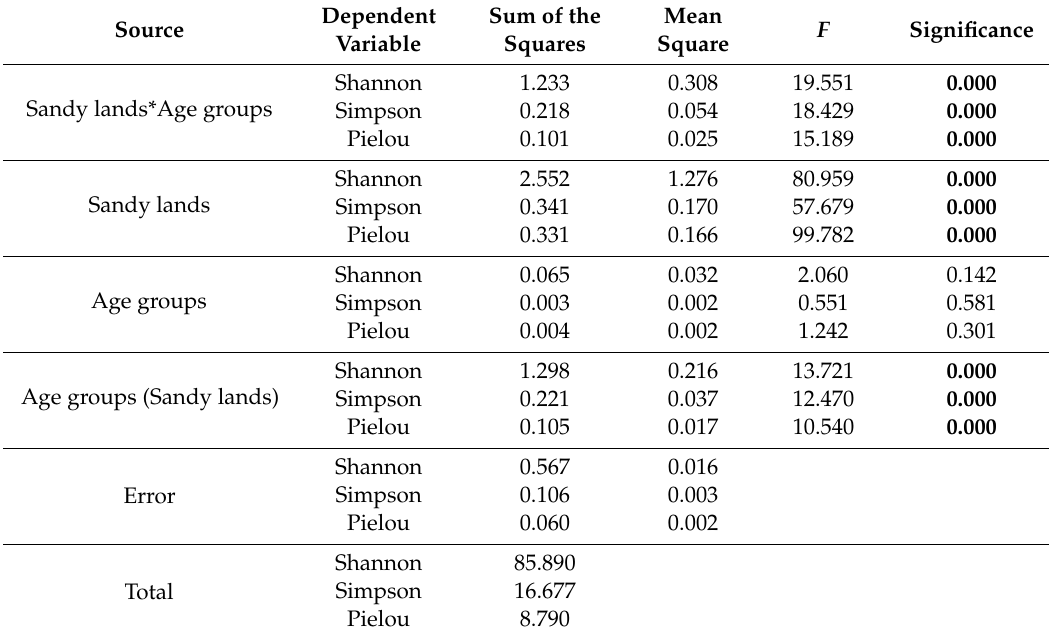
Table 2. Two-factor variance analysis of e ff ect of stand age and sandy land on EM fungal diversity. Dependent Sum of the Mean F Significance Source Variable Squares Square Sandy lands*Age groups